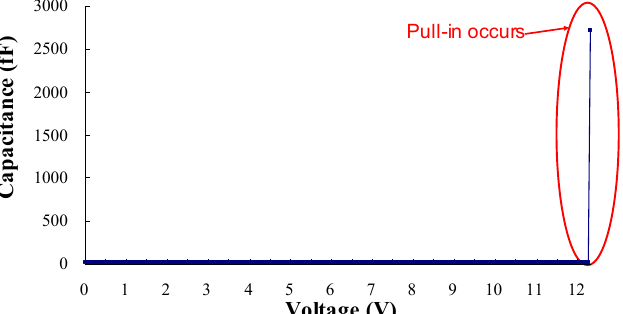
Figure 6. Typical sensitivities curves of the capacitances with respect to applied bias voltages of the test beam.